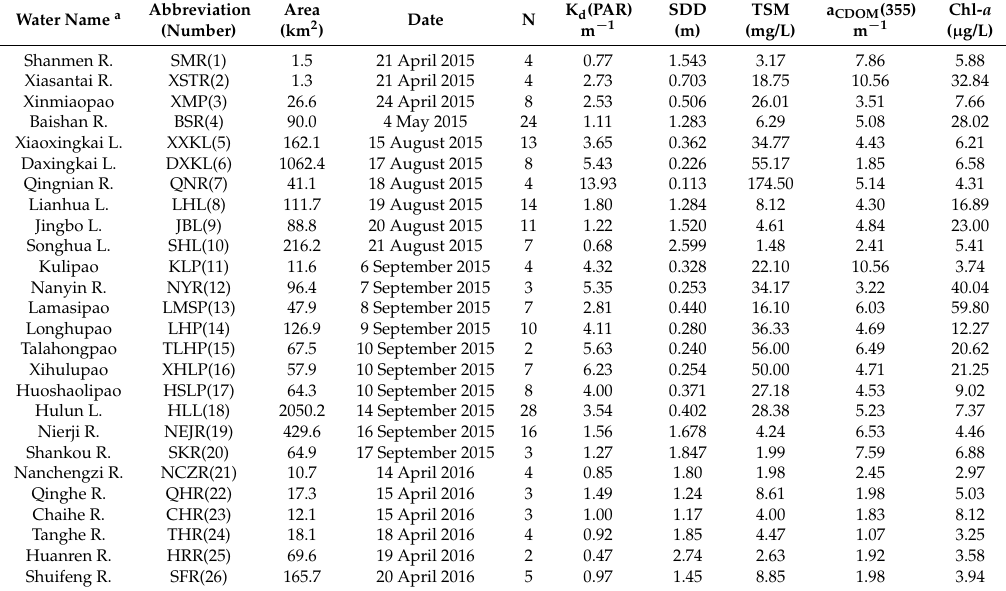
Table 1. Summaries of sample points and average values of optical parameters of the sampling lakes. N: counts of sample points; SDD: Secchi disk depth; TSM: total suspended matter; a CDOM (355): the absorption coefficient of chromophroic dissolved organic matter (CDOM) at 355 nm; Chl- a : chlorophyll- a